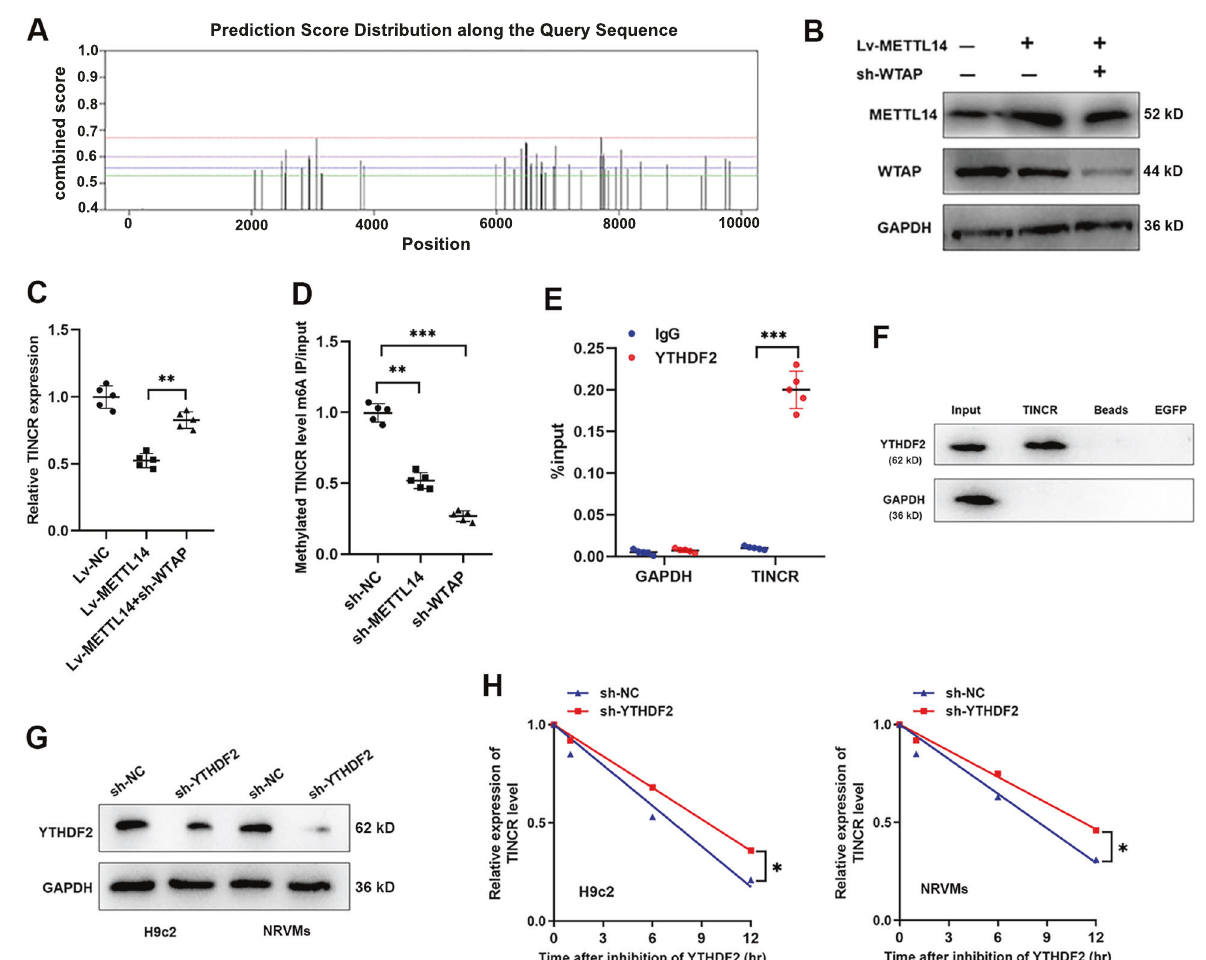
Fig. 6 TINCR was downregulated due to the METTL14-mediated m6A methylation. A Predicted binding sites of m6A modi fi cation at TINCR sequence according to the online SRAMP database (http://www.cuilab.cn/sramp). B METTL14-overexpression virus and sh-WTAP vector was injected into DCM rats. Protein band intensity of METTL14 and WTAP were quanti fi ed by western blot assay. C TINCR expression was determined in rats injected with Lv-METTL14 and(or) sh-WATP, ** P < 0.01. D Methylated TINCR level was detected via RIP assay, and a signi fi cant downregulation by silence of WTAP and METTL14 was observed, ** P < 0.01, *** P < 0.001. E RIP assay using YTHDF2 antibody revealed a signi fi cant association with TINCR, *** P < 0.001. F RNA pulldown experiment showed that YTHDF2 was enriched by TINCR probe. G Western blot validation of YTHDF2 protein following the transfection of sh-YTHDF2 vector. H Two cardiomyocyte cell lines were treated with AtcD, then existing TINCR was detected. Silence of YTHDF2 signi fi cantly increased degradation of TINCR, * P <